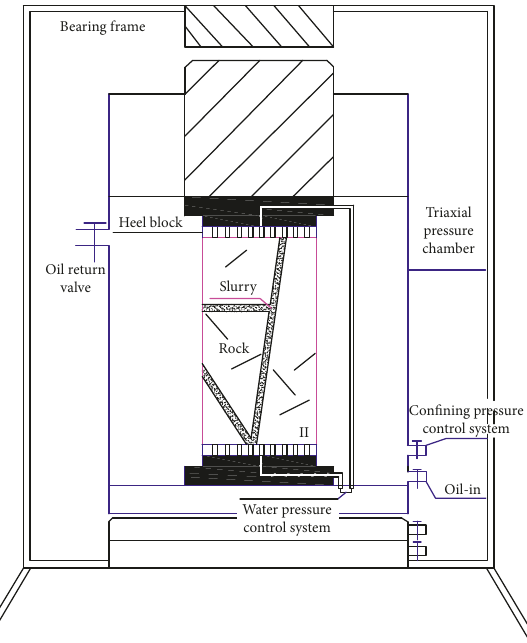
Figure 2: Explanatory sketch of the mechanical test